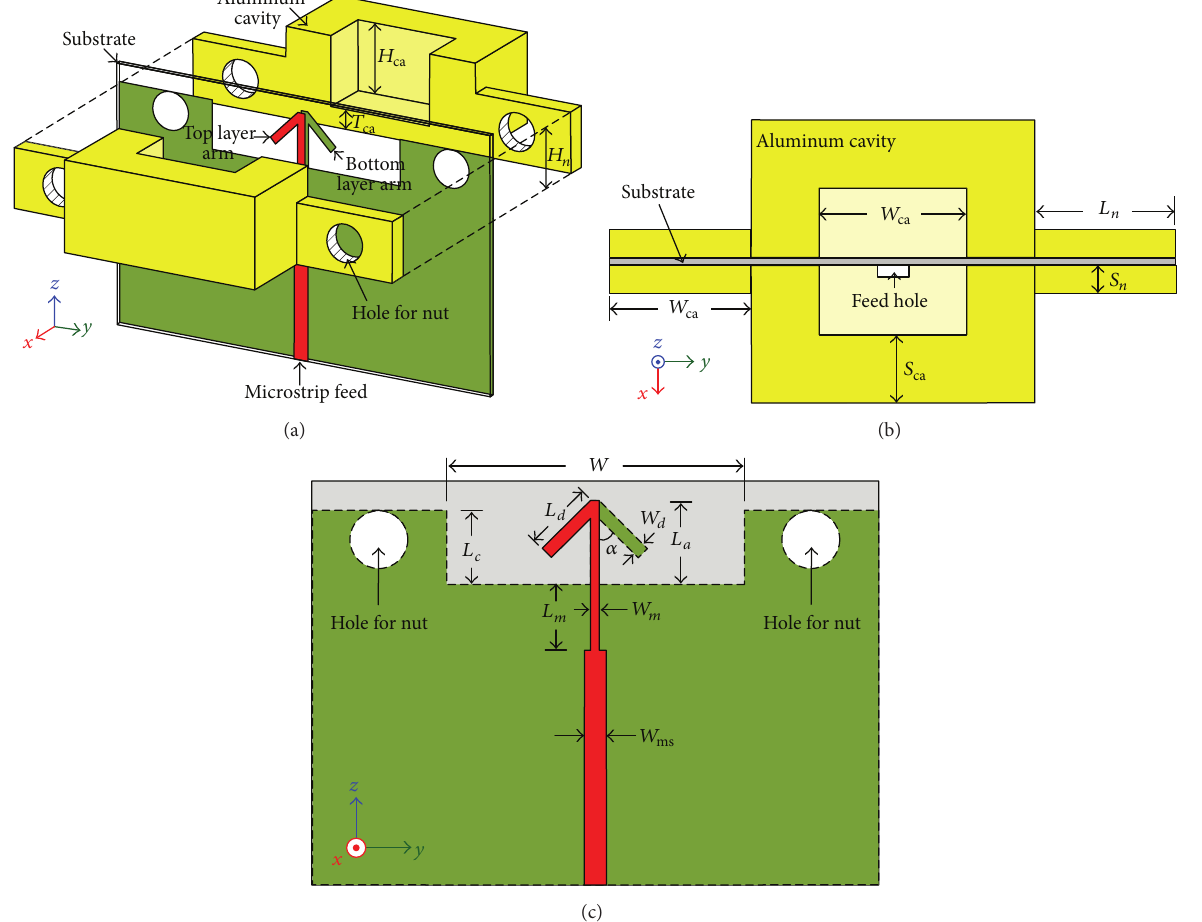
Figure 1: Geometry of the cavity-backed angled-dipole antenna: (a) perspective view, (b) top view, and (c) angled-dipole radiator.